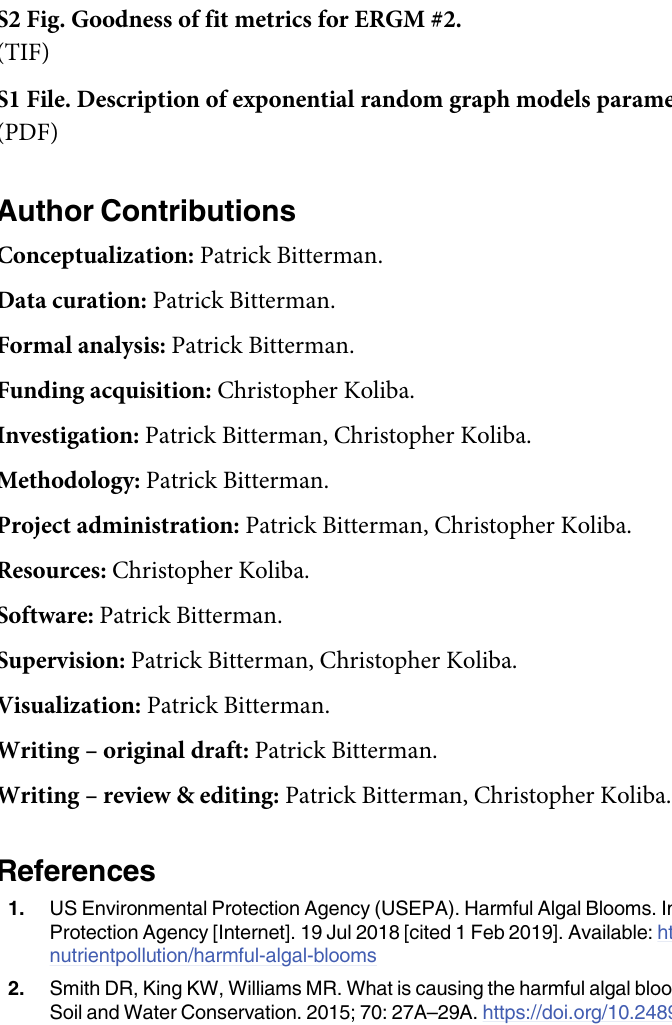
S1 Fig. Goodness of fit metrics for ERGM #1. S2 Fig. Goodness of fit metrics for ERGM #2. S1 File. Description of exponential random graph models parameters and